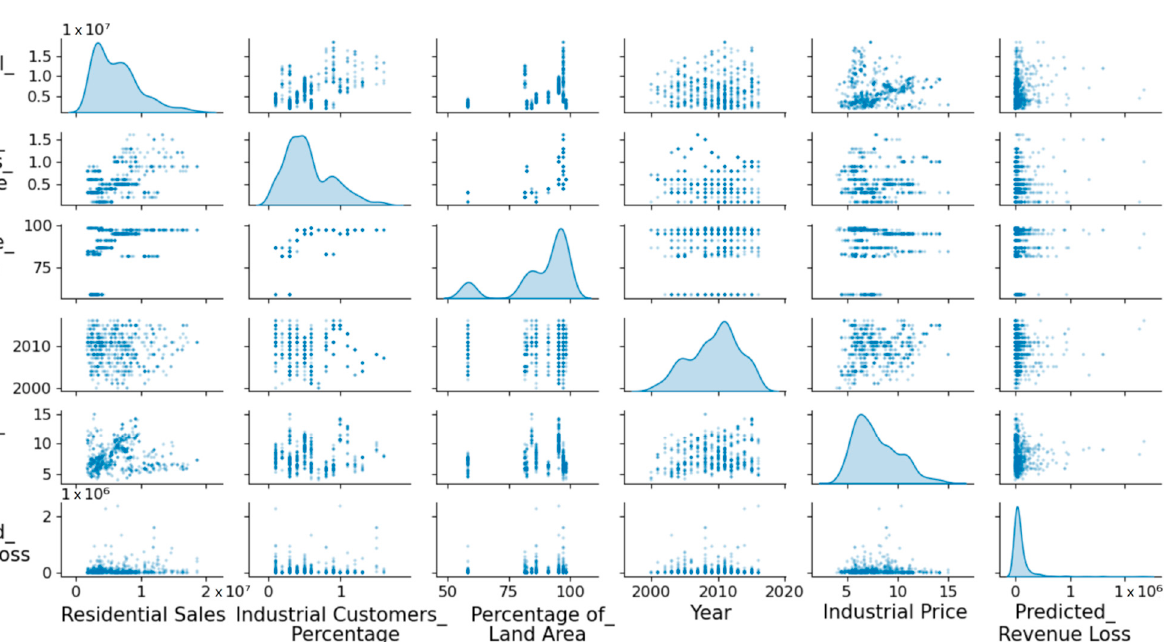
Figure 18. Heat map of Pearson correlation coefficients among top 10 important features.